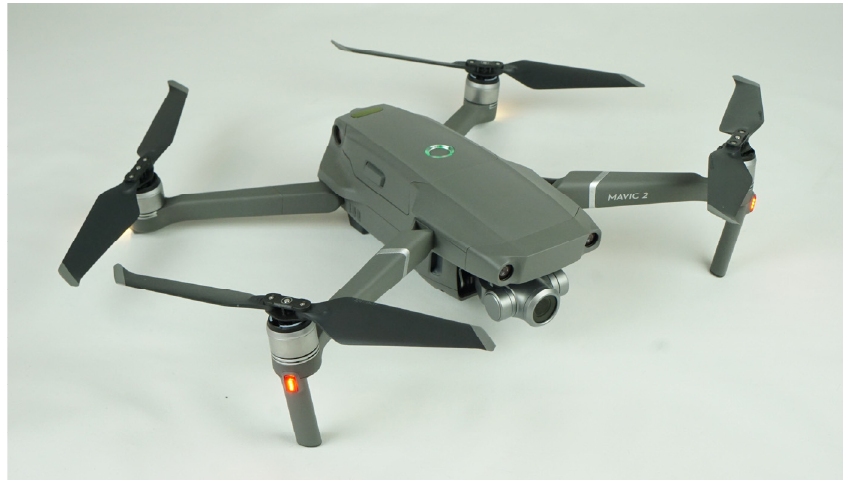
Figure 2. DJI- Mavic 2 Zoom. Figure 2. DJI-Mavic 2